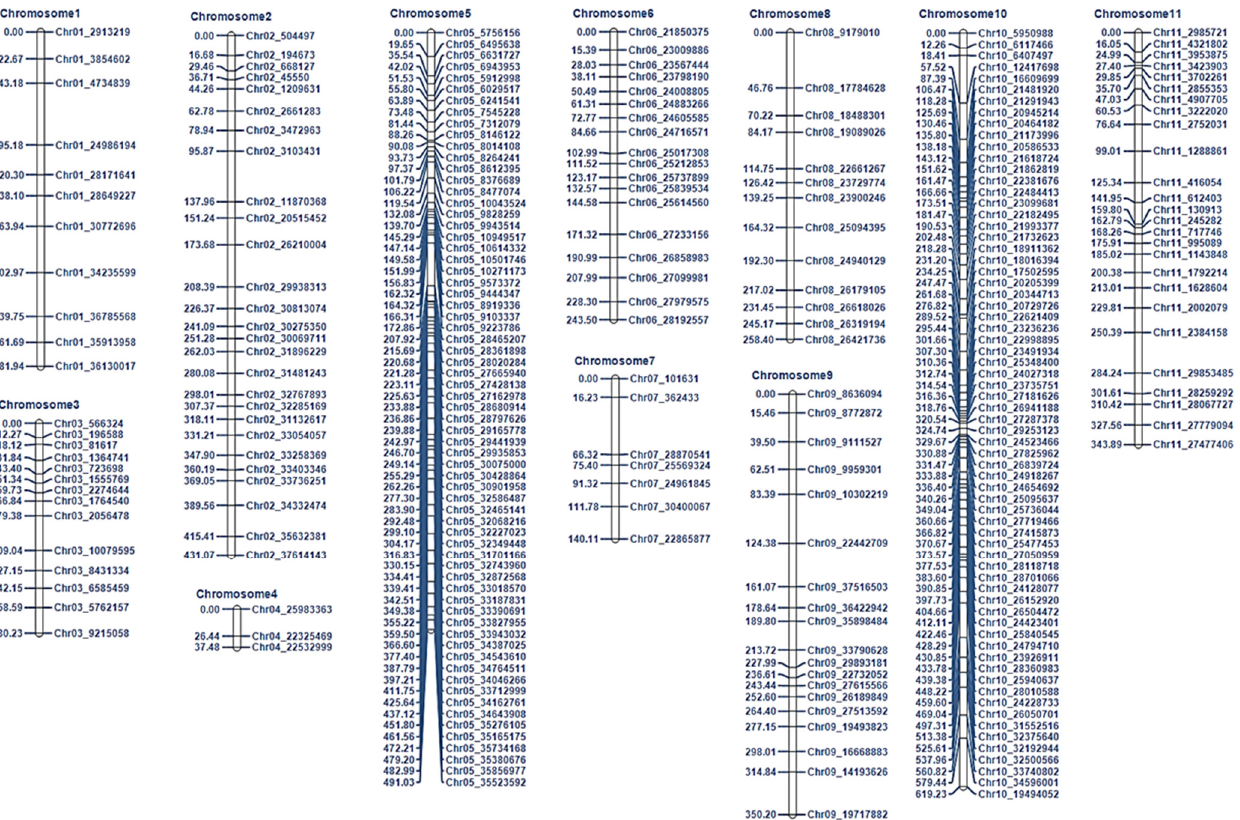
Figure 3. Genetic map of watermelon (SW 26 × PI 189225) segregating F 2 mapping population comprising 275 genotyping by sequencing (GBS) derived SNP markers. The numbers on the left side represent the genetic distance from the top of each chromosome in cM. The names on the right side represent the name of the marker.